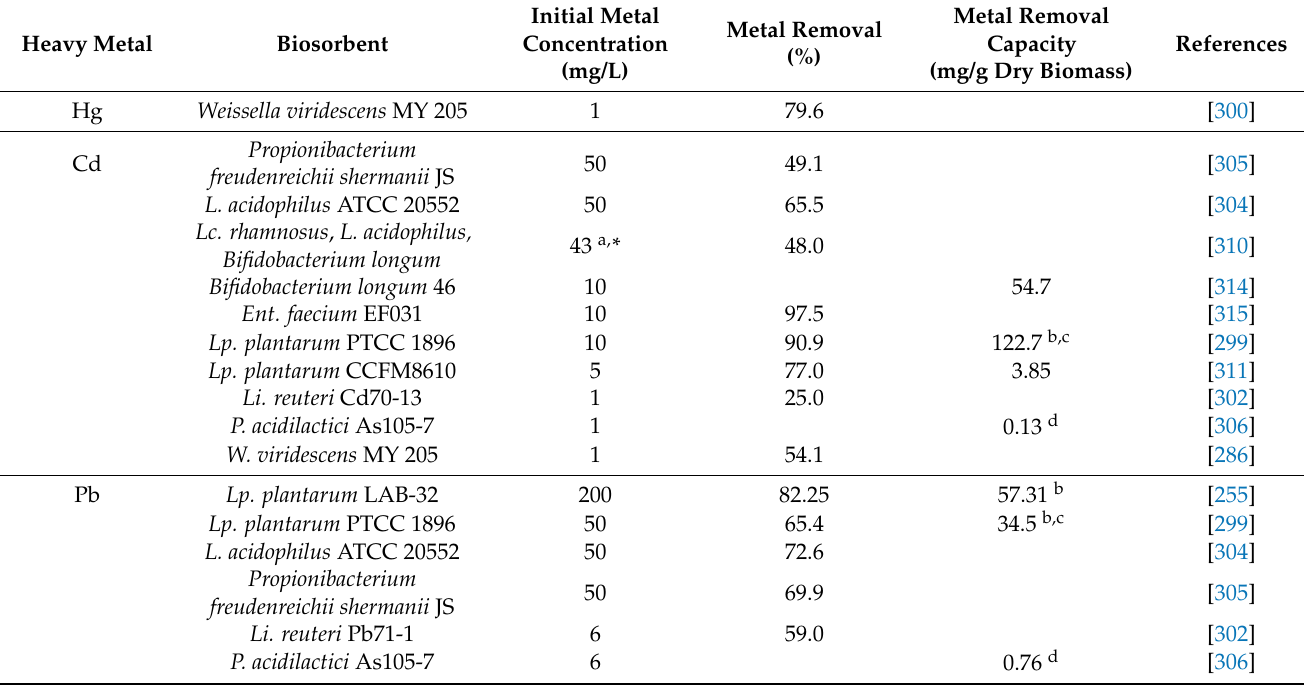
Table 8. In vitro biosorption of heavy metals by living LAB and Bifidobacterium